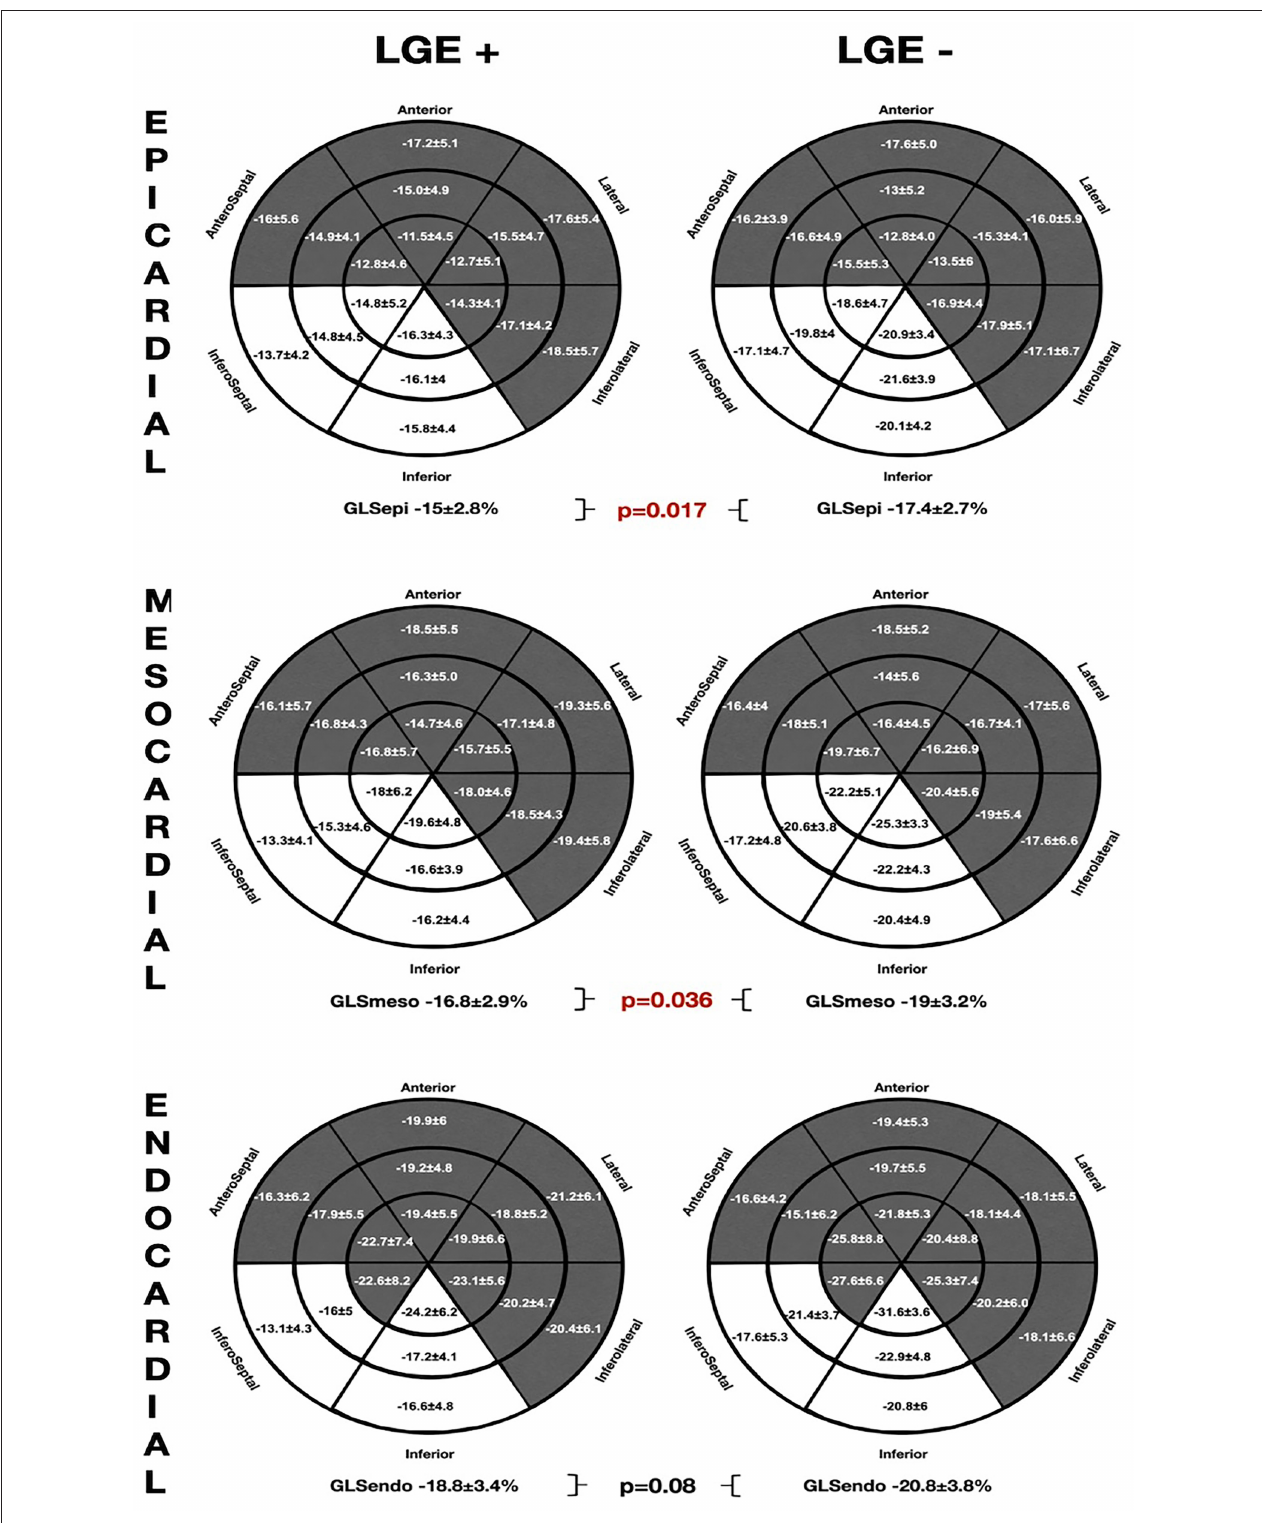
FIGURE 4 | The comparative global and regional layer-specific GLS analysis global between the LGE ( + ) and LGE (–) groups represented in the LV 18-segment models according to each myocardial layer. White areas remark significant differences in regional longitudinal strain between the groups. GLS, global longitudinal strain; LGE, late gadolinium